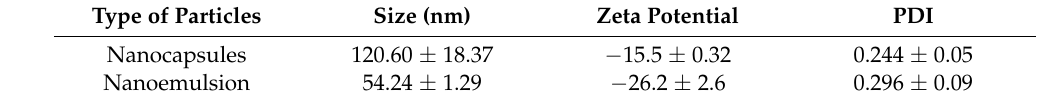
Table 2. Average size and z-Potential of O. glandulosum Desf. oil nanoemulsion and nanoencapsulation.